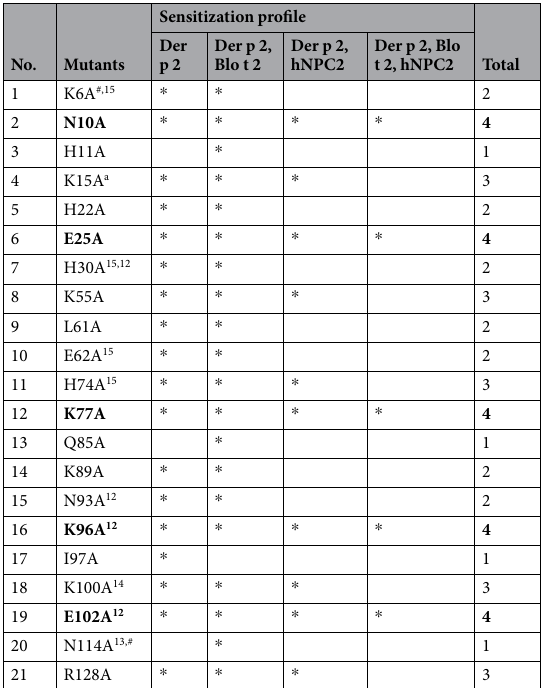
Table 1. Summary of IgE reactions of house dust mite allergic individuals to Der p 2 site directed mutants based on sensitization profiles. Superscripts describes residues that has been previously described in other publications. The areas marked with asterisks ( * ) indicate that the IgE binding to individual mutants were < 75% compared to WT Der p 2 in at least 40% of the population. Mutants in bold had reduced IgE binding across all sensitization profiles. # Residues which were similar in Der p 2 and hNPC2, but selected as they reported as IgE epitopes in previous